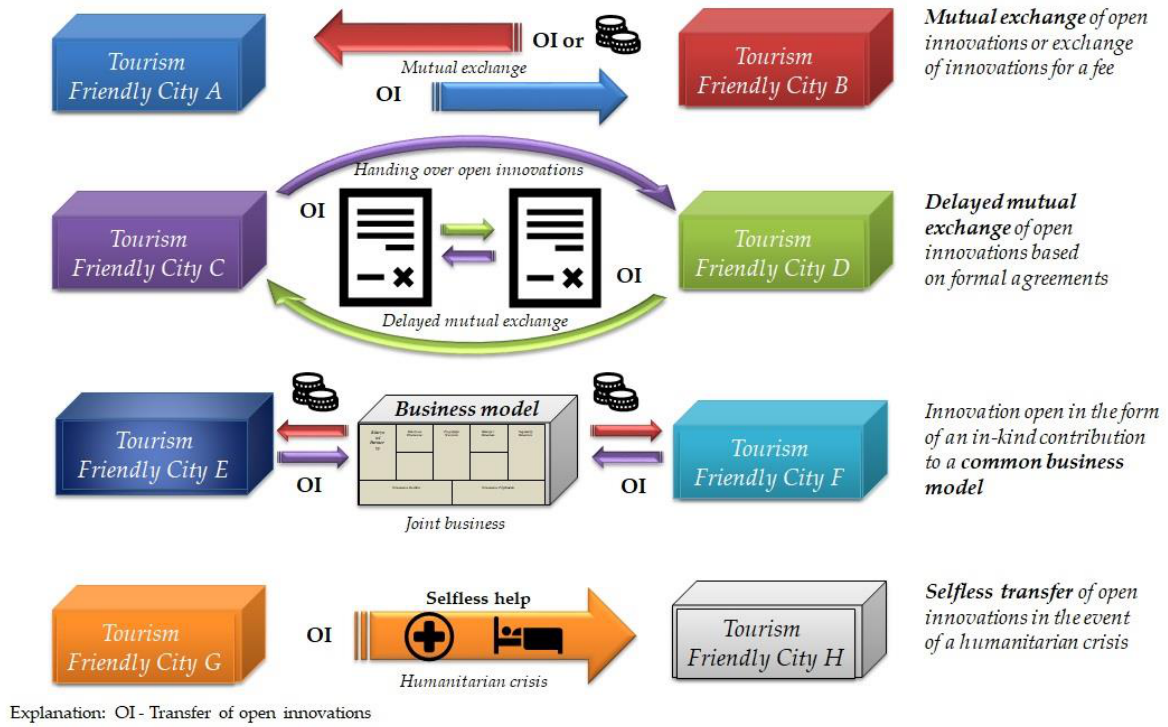
Figure 8. Forms of open innovation transfer. Source: Own study.